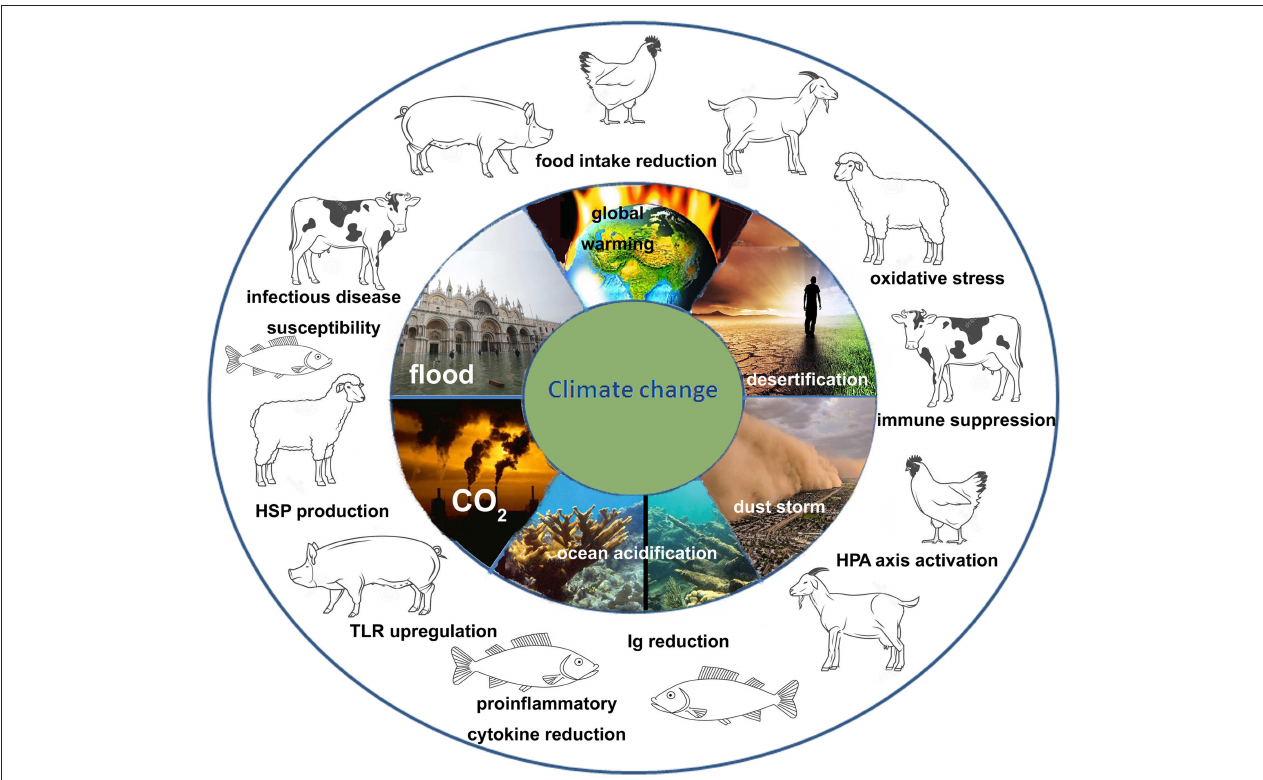
FIGURE 1 | Scheme of the impact of climate change on the immune system of livestock animals. Climate change is a complex phenomenon that include different dramatic event such as global warming, desertification, alteration of water cycle leading to floods and droughts, increase concentration of atmospheric CO 2 , acidification, and alteration of the salinity of the oceans. All these events deeply affect the immune system of livestock species (mammals, avian, and fishes) both directly and indirectly. Many of the responses are common to different animals such as the activation of the HPA axis with the release of cortisol (that is an immune suppressor), production of HSPs in response to the oxidative stress, reduction of Ig production and increased susceptibility to infectious